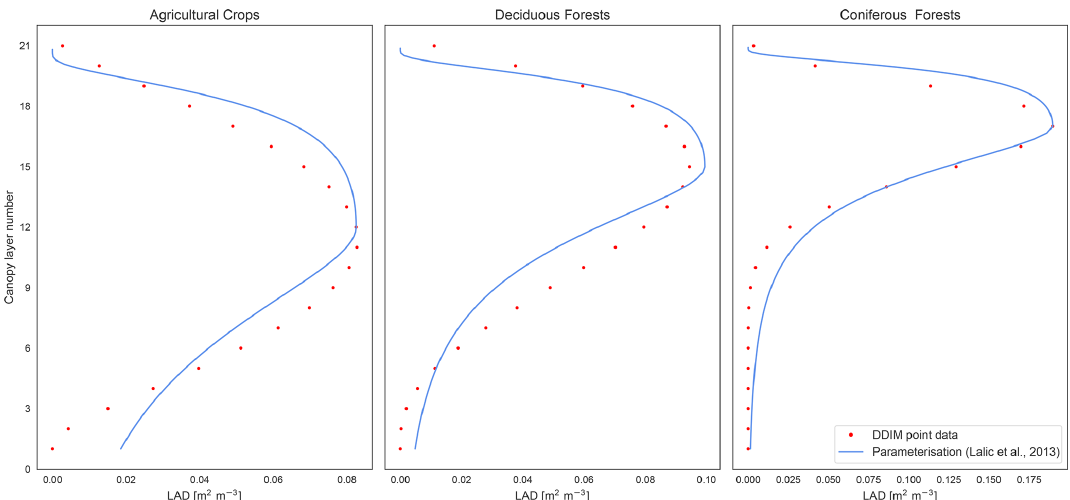
Figure 4. LAD distribution for a 21-layer canopy using DDIM point data versus the continuous distribution from the employed parameteri- sation for the three vegetation